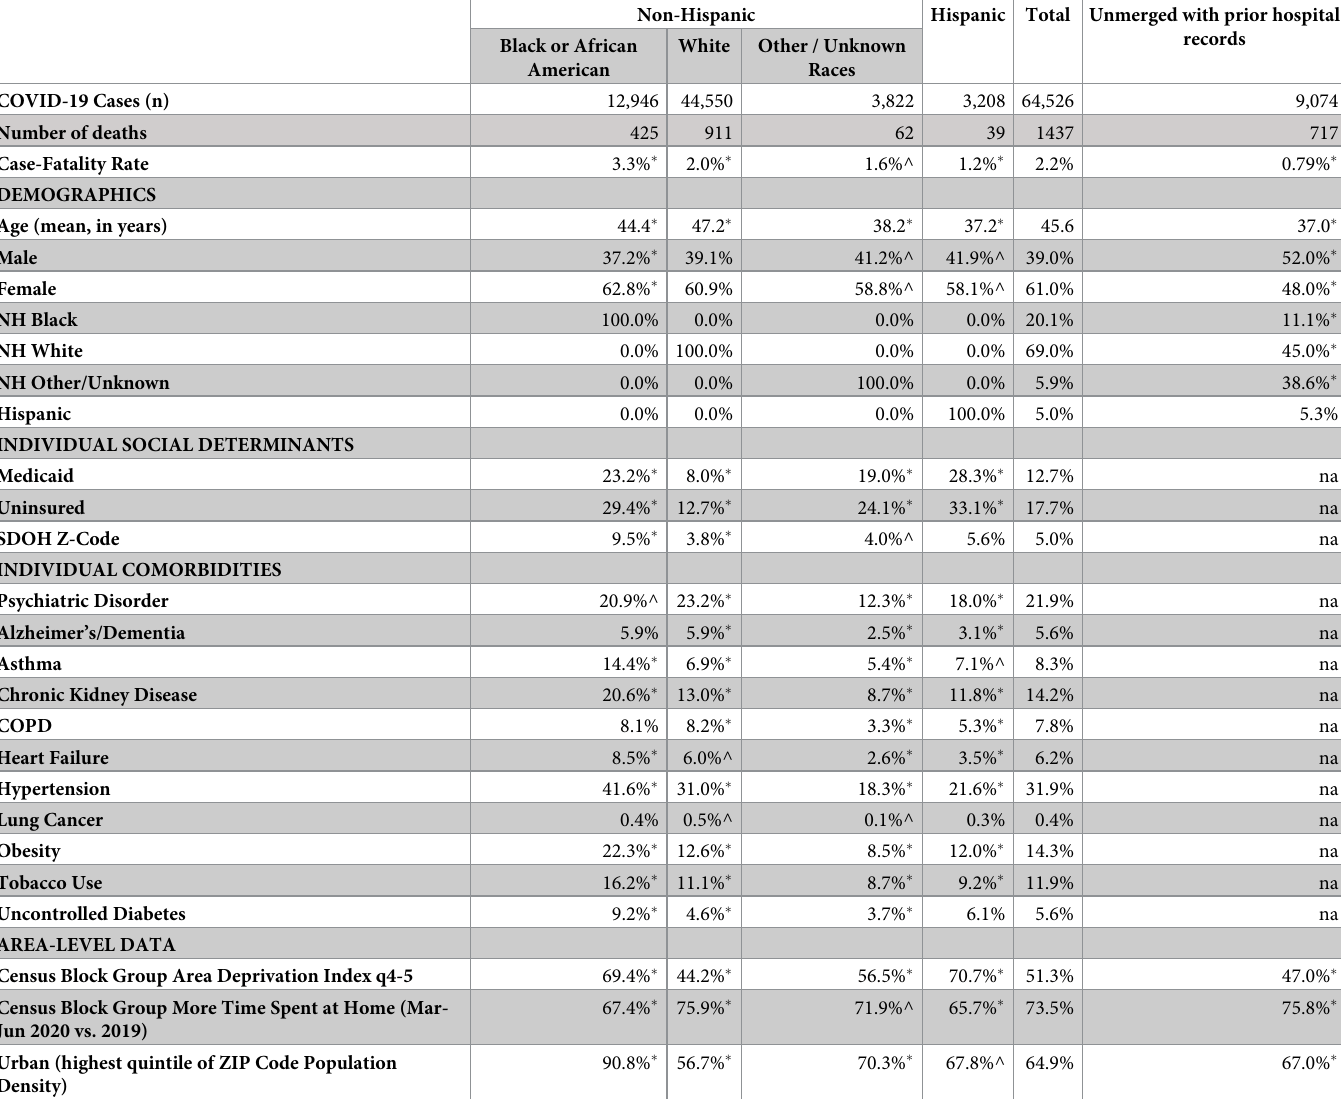
Table 1. Patient characteristics by race and